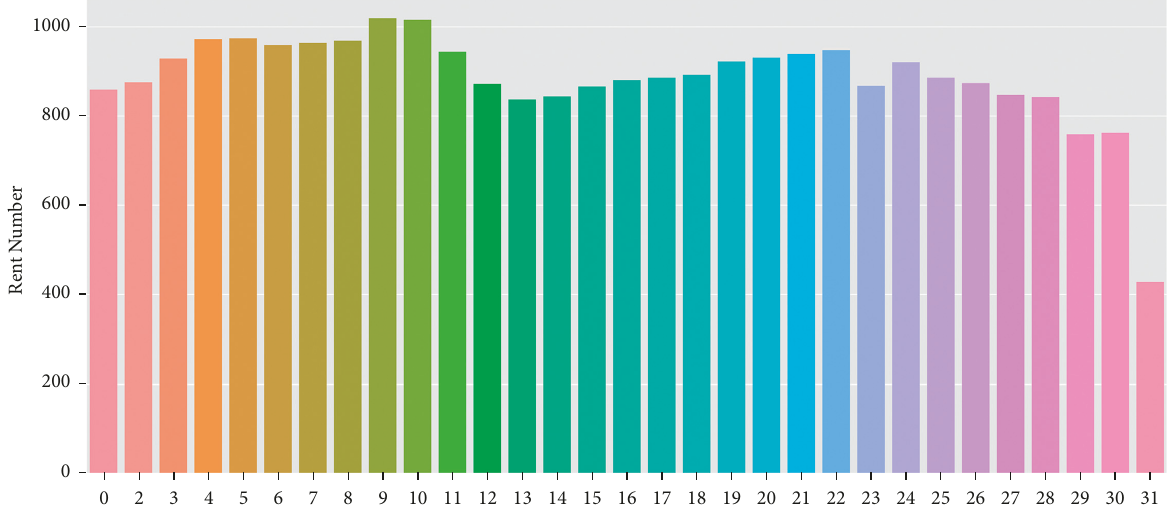
Figure 9: Total Demand on each day of a month.